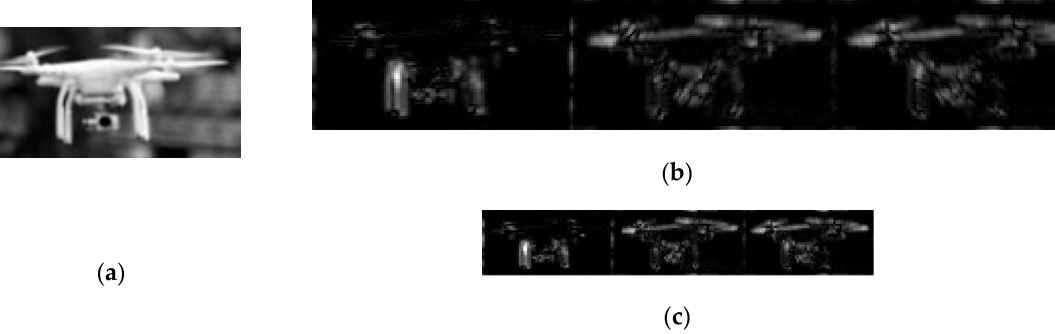
Figure 4. UAV image Log-Gabor filtering and downsampling: ( a ) source image; ( b ) Log-Gabor filtering images; ( c ) downsampling image of Figure 4b.